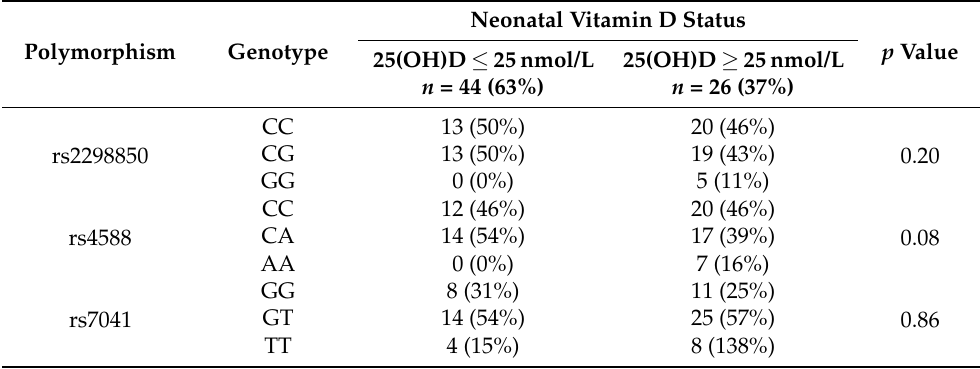
Table 10. Genotype distribution of maternal VDBP polymorphisms according to neonatal vitamin